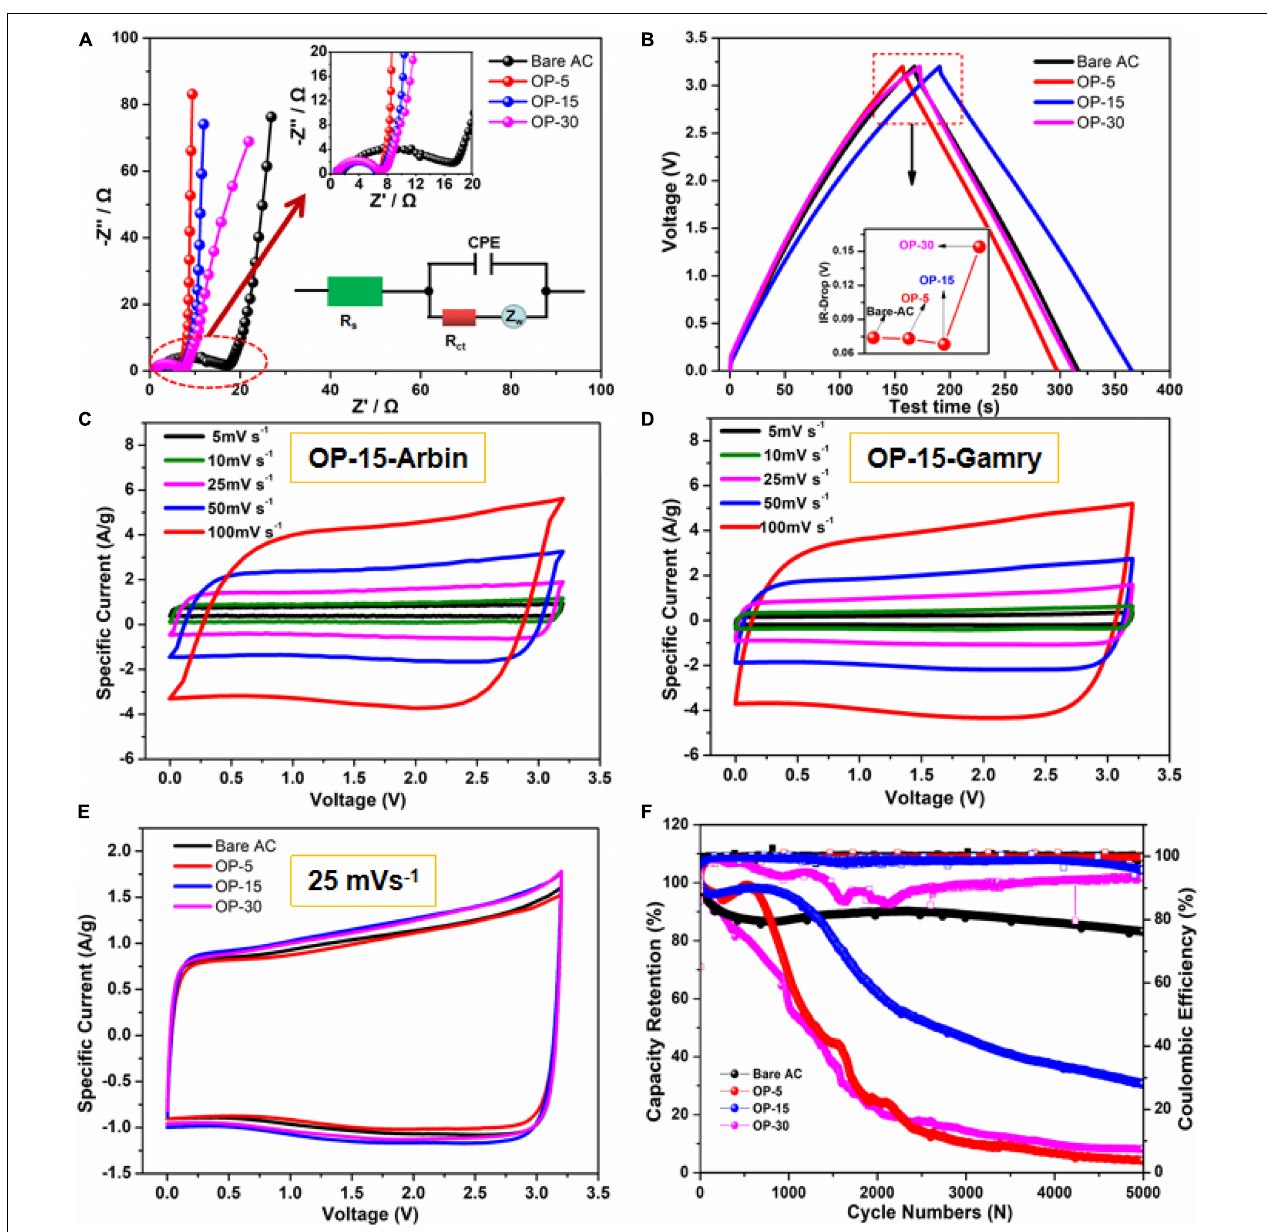
FIGURE 4 | (A) Electrochemical impedance spectra of Bare AC and OP-x; (B) A comparison GCD curves at 5 mA cm - 2 of Bare AC and OP-x (the inset shows their IR-drop curves t); (C) C-V curves of OP-15 using Arbin; (D) C-V curves of OP-15 using Gamry; (E) C-V curves at 25 mV s - 1 of Bare AC and OP-x; and (F) Cycling stability of Bare AC and OP-x at 3.2